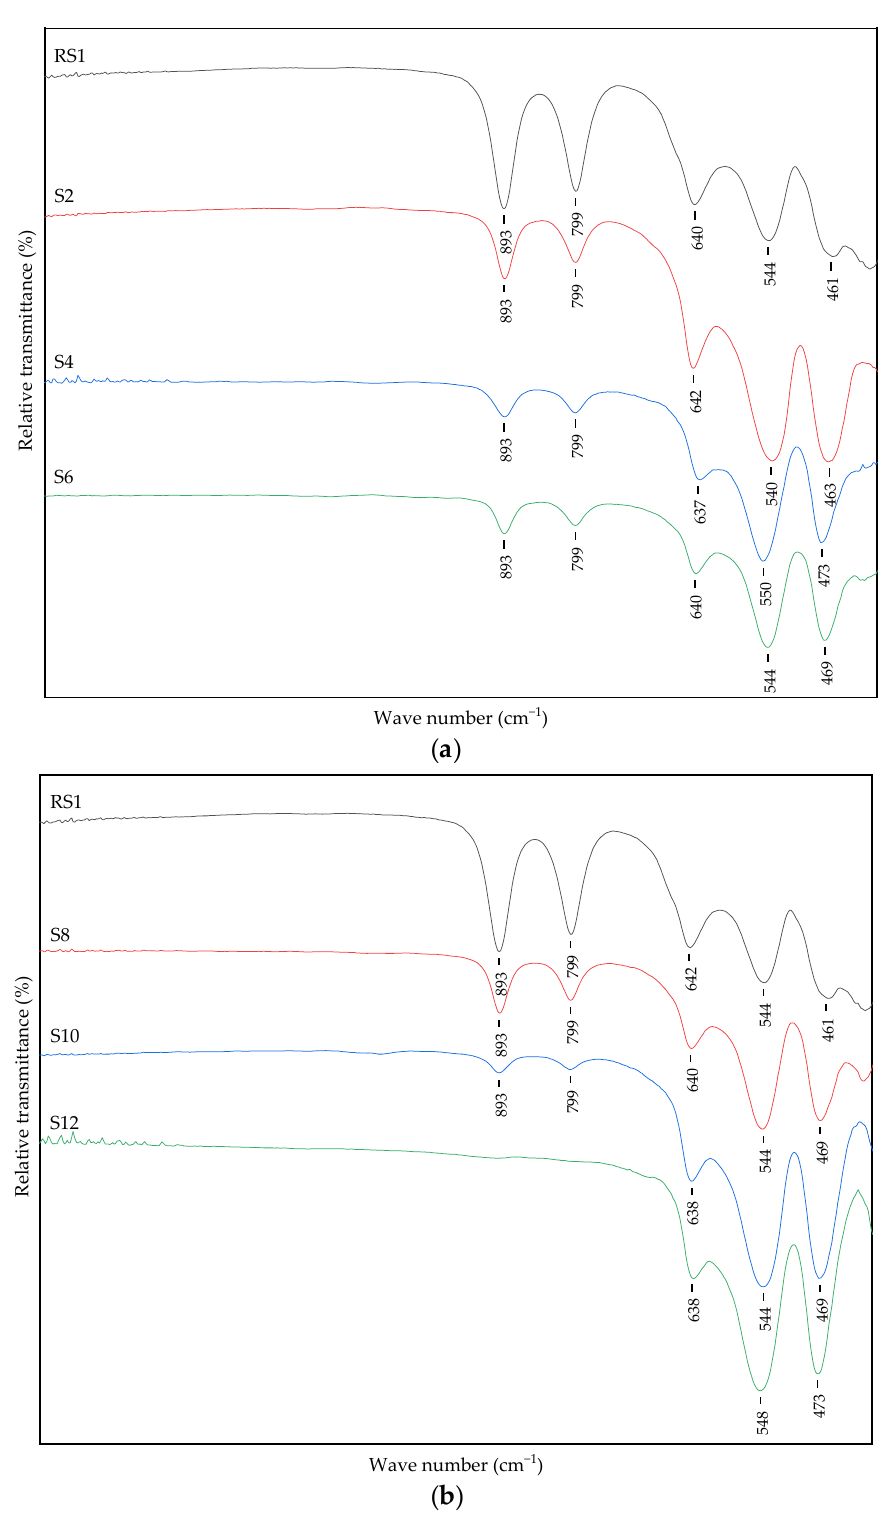
Figure 1. FTIR spectra of the reference sample and samples with the addition of ( a ) 4.5% surfactants and ( b ) 4.5% essential oils prepared at 200 °C for 20 min.